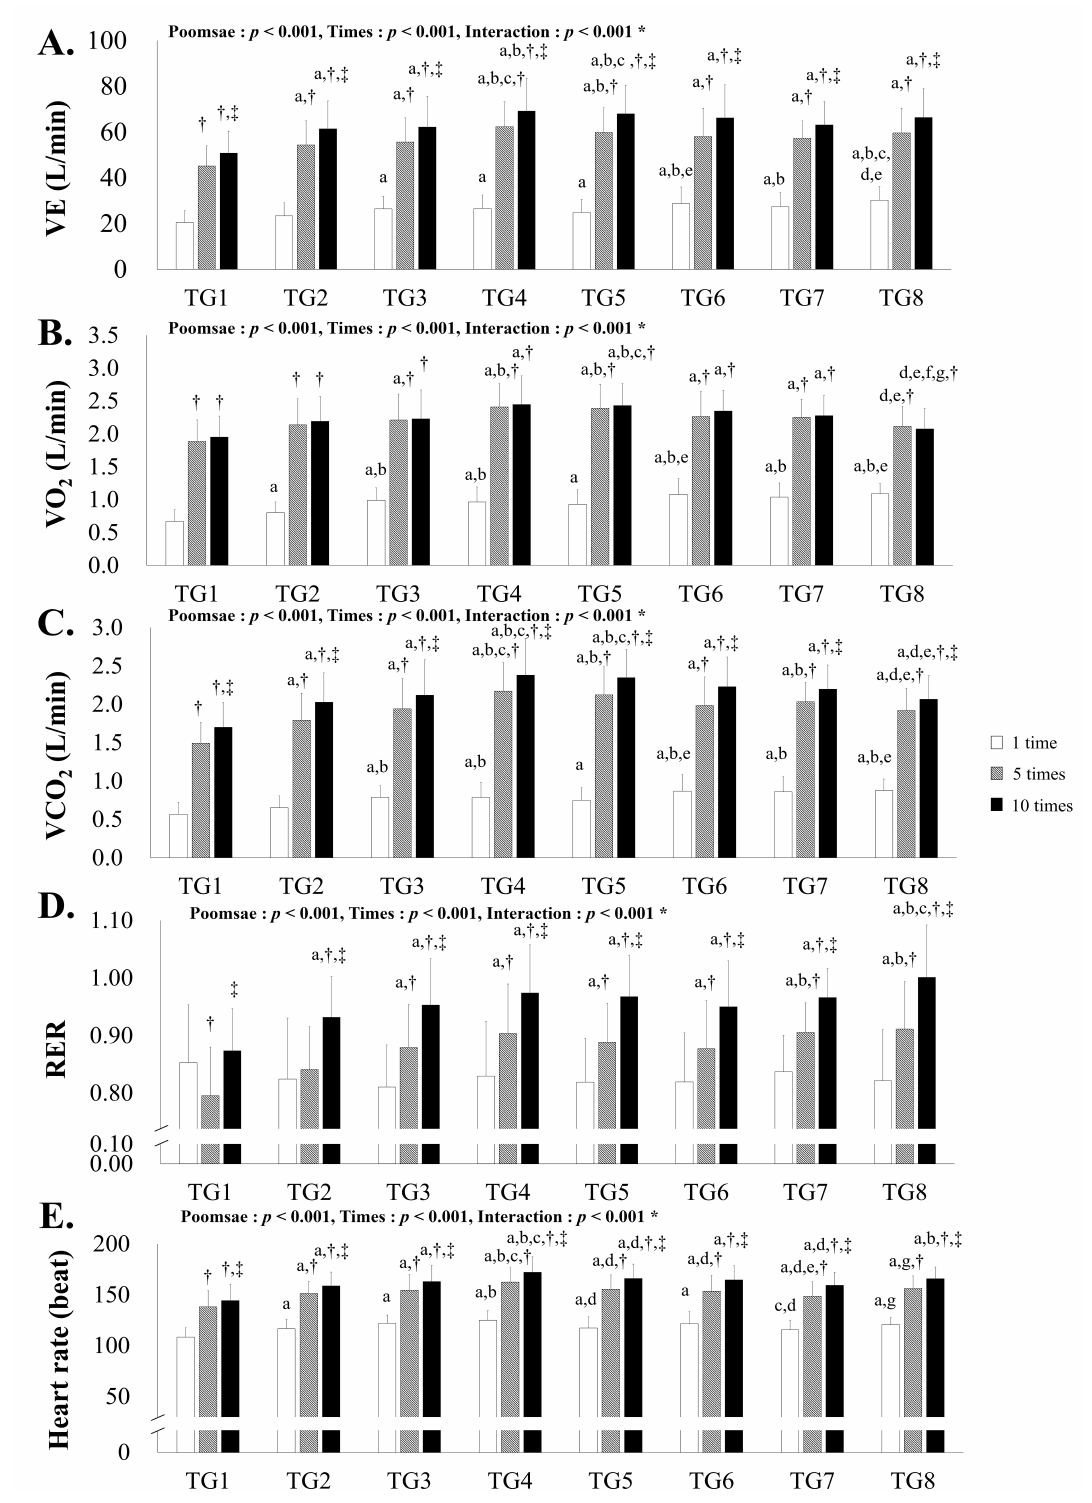
Fig. 3. Cardiopulmonary function of Taekwondo Taegeuk Poomsae (mean ± standard deviation). (A) Change in VE, (B) change in VO 2 , (C) change in VCO 2 , (D) change in RER, (E) change in HR are shown. TG, Taegeuk; VE, minute ventilation; VO 2 , oxygen uptake; VCO 2 , carbon dioxide excretion; RER, respiratory exchange ratio; HR, heart rate. a: p < 0.05 vs. TG1, b: p < 0.05 vs. TG2, c: p < 0.05 vs. TG3, d: p < 0.05 vs. TG4, e: p < 0.05 vs. TG5, f: p < 0.05 vs. TG6, g: p < 0.05 vs. TG7. †: p < 0.05 vs. 1st repetition, ‡: p < 0.05 vs. 5th